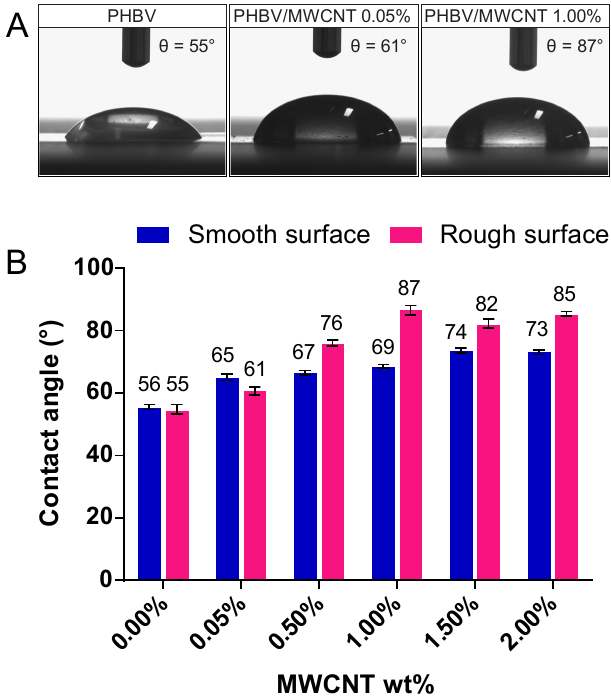
Figure 6. ( A ) Contact angle in the rough surface of PHBV after the addition of 0.05 and 1.00% (w/w) of MWCNTs. ( B ) Contact-angle values of smooth and rough surfaces of PHBV/MWCNT nanocomposites. Table 3. Tensile modules (E), tensile strength ( σ max) and elongation at break ( ε max) of neat PHBV and